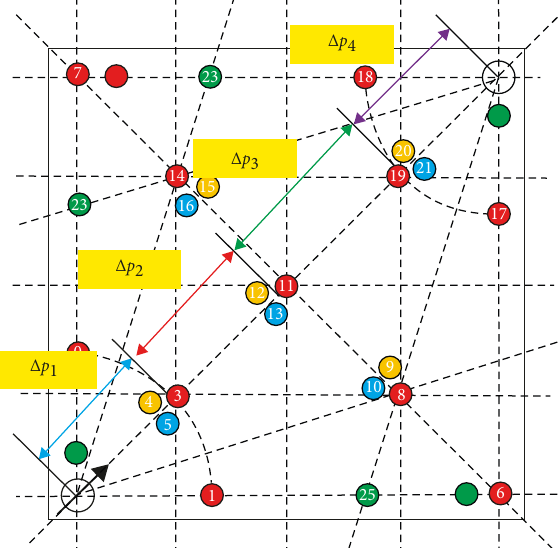
Figure 13: Schematic diagram of pressure differences along the main streamline.